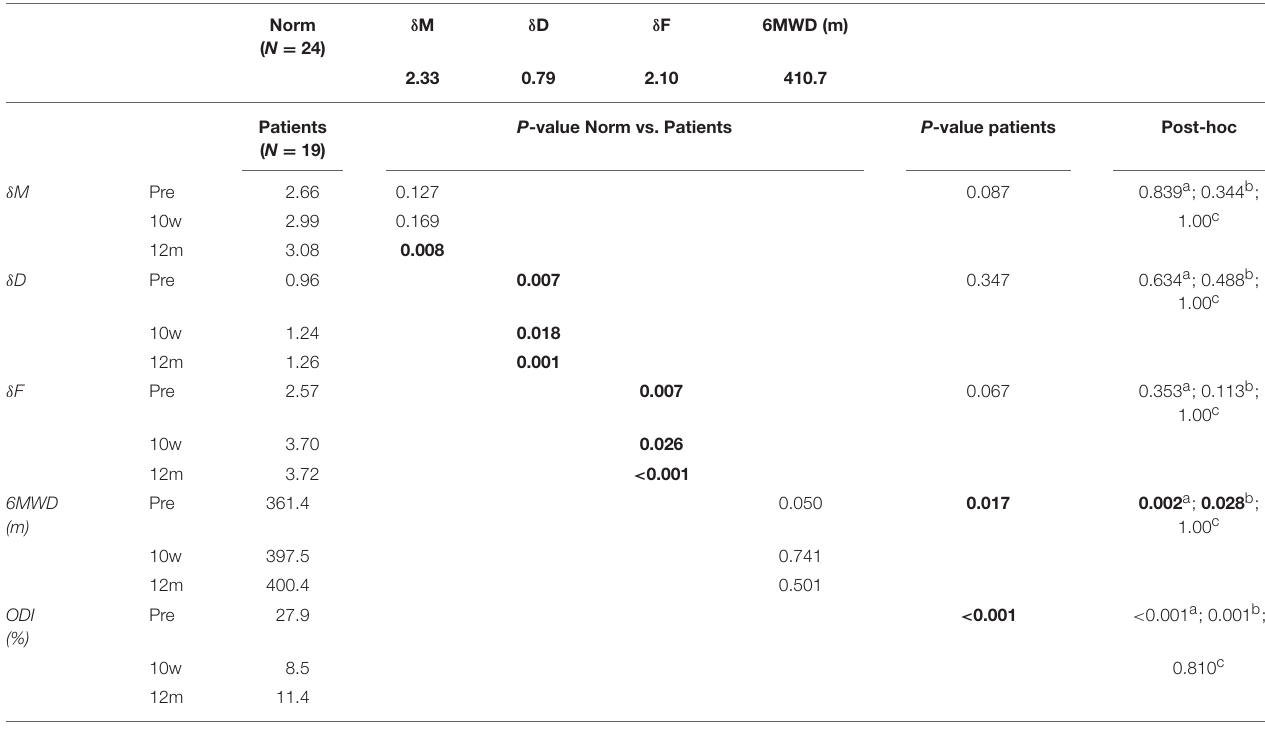
TABLE 2 | Mean values and statistical results of the attractor analysis in healthy persons and patients with